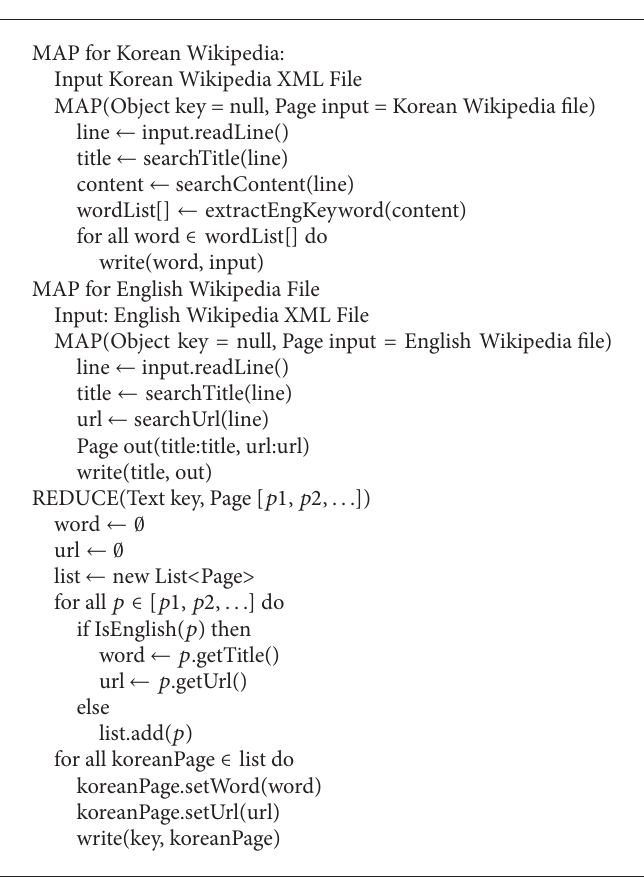
Algorithm 7: MapReduce pseudocode for the join